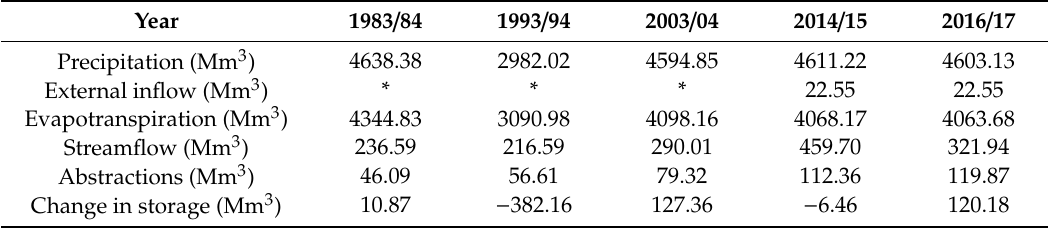
Figure 12. Comparison of observed and simulated streamflow using R 2 . 3.2. Discussion Hydrological Water Balance for Chongwe River Catchment and Its Components The model shows that the major component of water inflow into the catchment is precipitation (Figure 10). The observed trend for a period of 34 years shows that precipitation is decreasing at a rate of 0.12 Mm 3 /year. This decrease agrees with the findings in the study by Chisola et al. [28] in which the decrease was attributed to climate change. The model further shows another external water inflow consisting of a considerable volume of water transferred from the Kafue River catchment into Chongwe River catchment through the LWSC System. The Lusaka Water Sewerage Company abstracts 226,000 m 3 of water per day of which 96,000 m 3 is from the Kafue River and 130,000 m 3 is from groundwater sources [29]. The production boreholes located in Chongwe River catchment supplies about 51,024 cubic meters of water per day of water which is 22.6% of the total water supply of Lusaka City [30]. Therefore, the volume of water